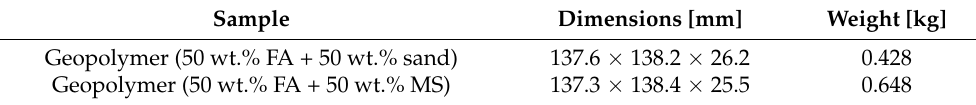
Table 3. Dimensions and weight of samples for testing thermal insulation